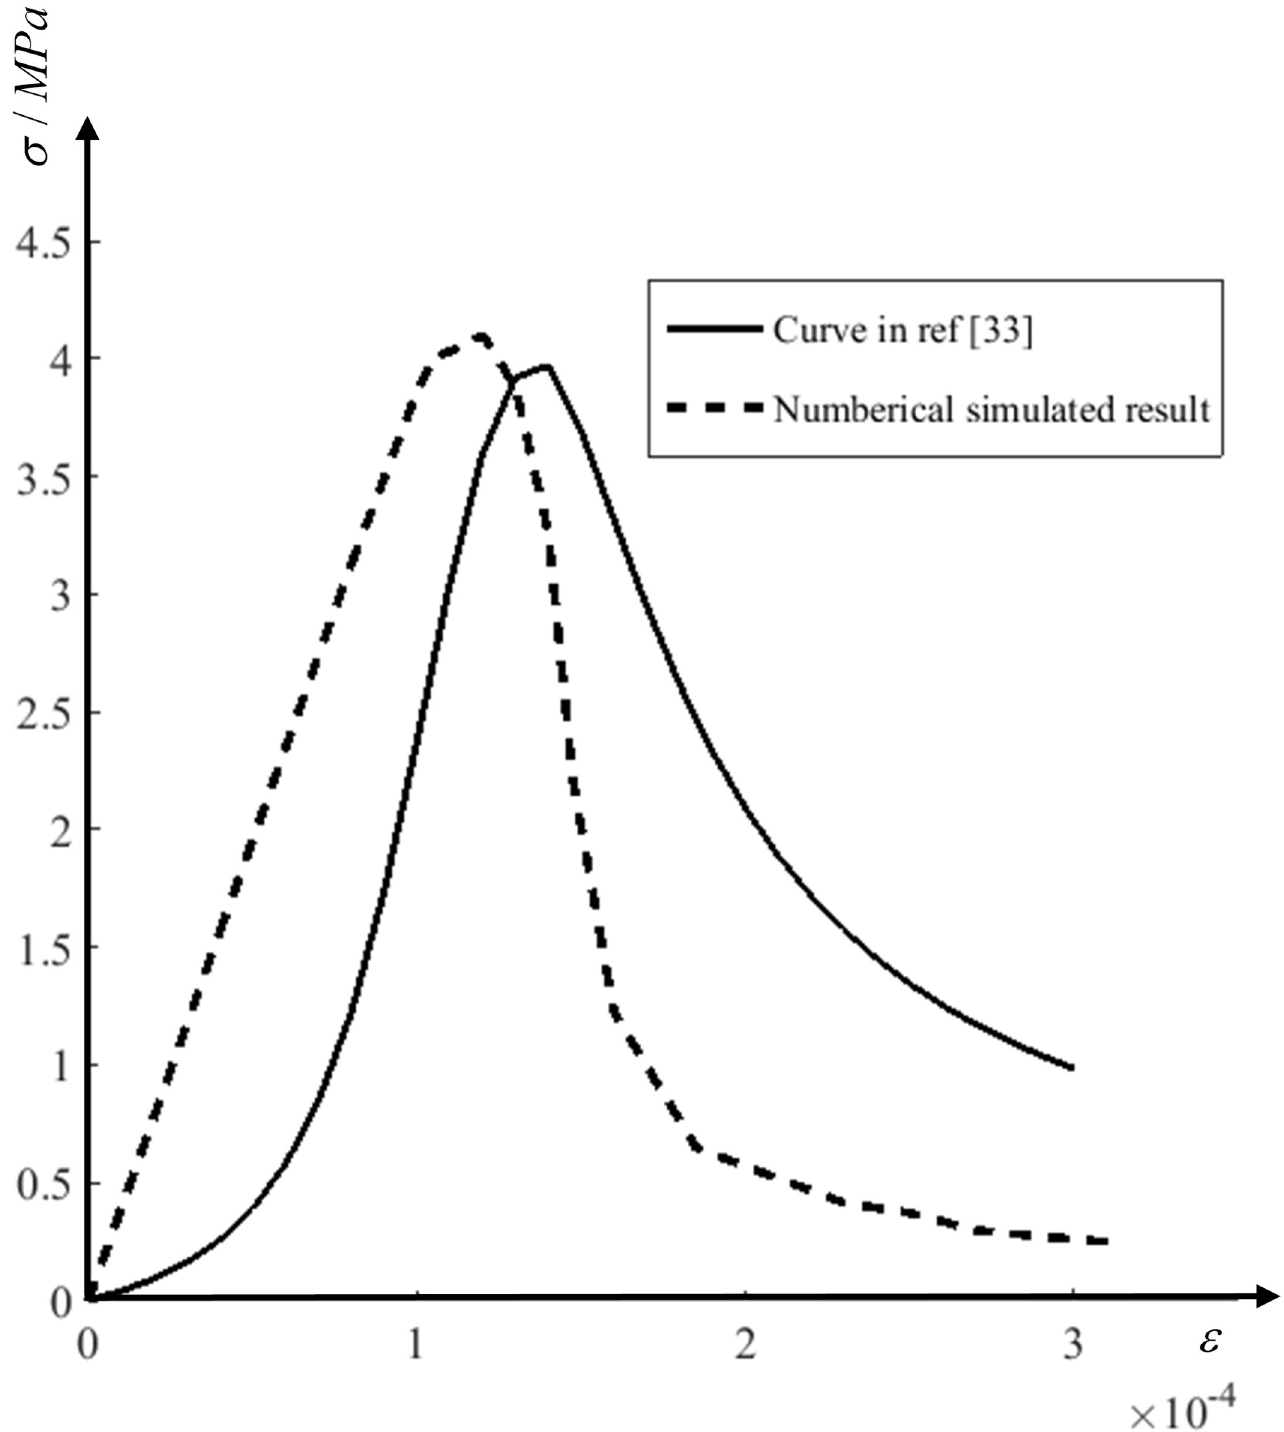
Fig 10. Stress-strain curves of concrete under uniaxial tension. The numerical result obtains from the FE model in Fig 9.